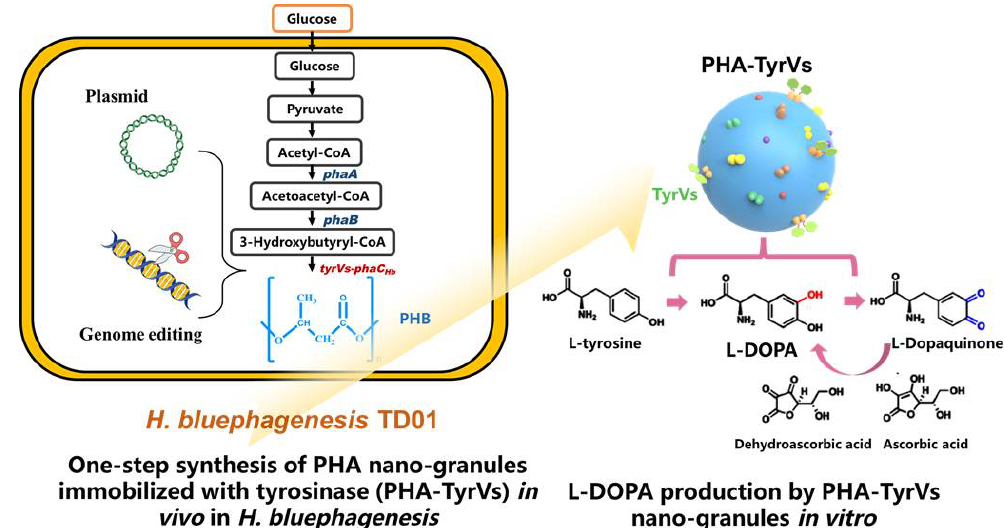
Figure 1. Engineering of Halomonas bluephagenesis TD strain for the production of TyrVs immobilized PHA nanogranules in vivo and the in vitro catalysis for L-DOPA production by PHA-TyrVs nanogranules. TyrVs-PhaC Hb fusion protein was expressed in plasmid or integrated expressed in genome in H. bluephagenesis TD strain, and the PHA-TyrVs nanogranules were produced with TyrVs-PhaC Hb protein displayed onto the surface of PHA simultaneously with native PHA synthesis from glucose. The biocatalyst was purified and subjected to efficient L-DOPA production in vivo in the presence of ascorbic acid to inhibit further oxidation.